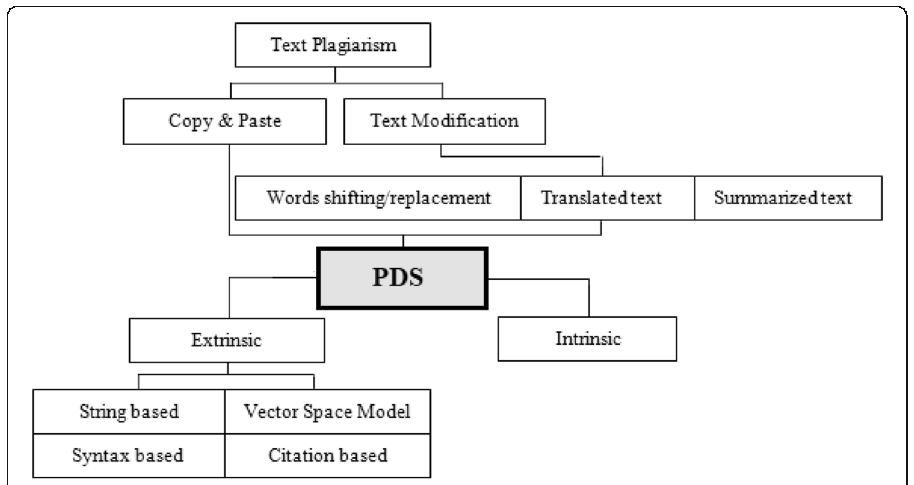
Fig. 1 Types of text plagiarism detection software